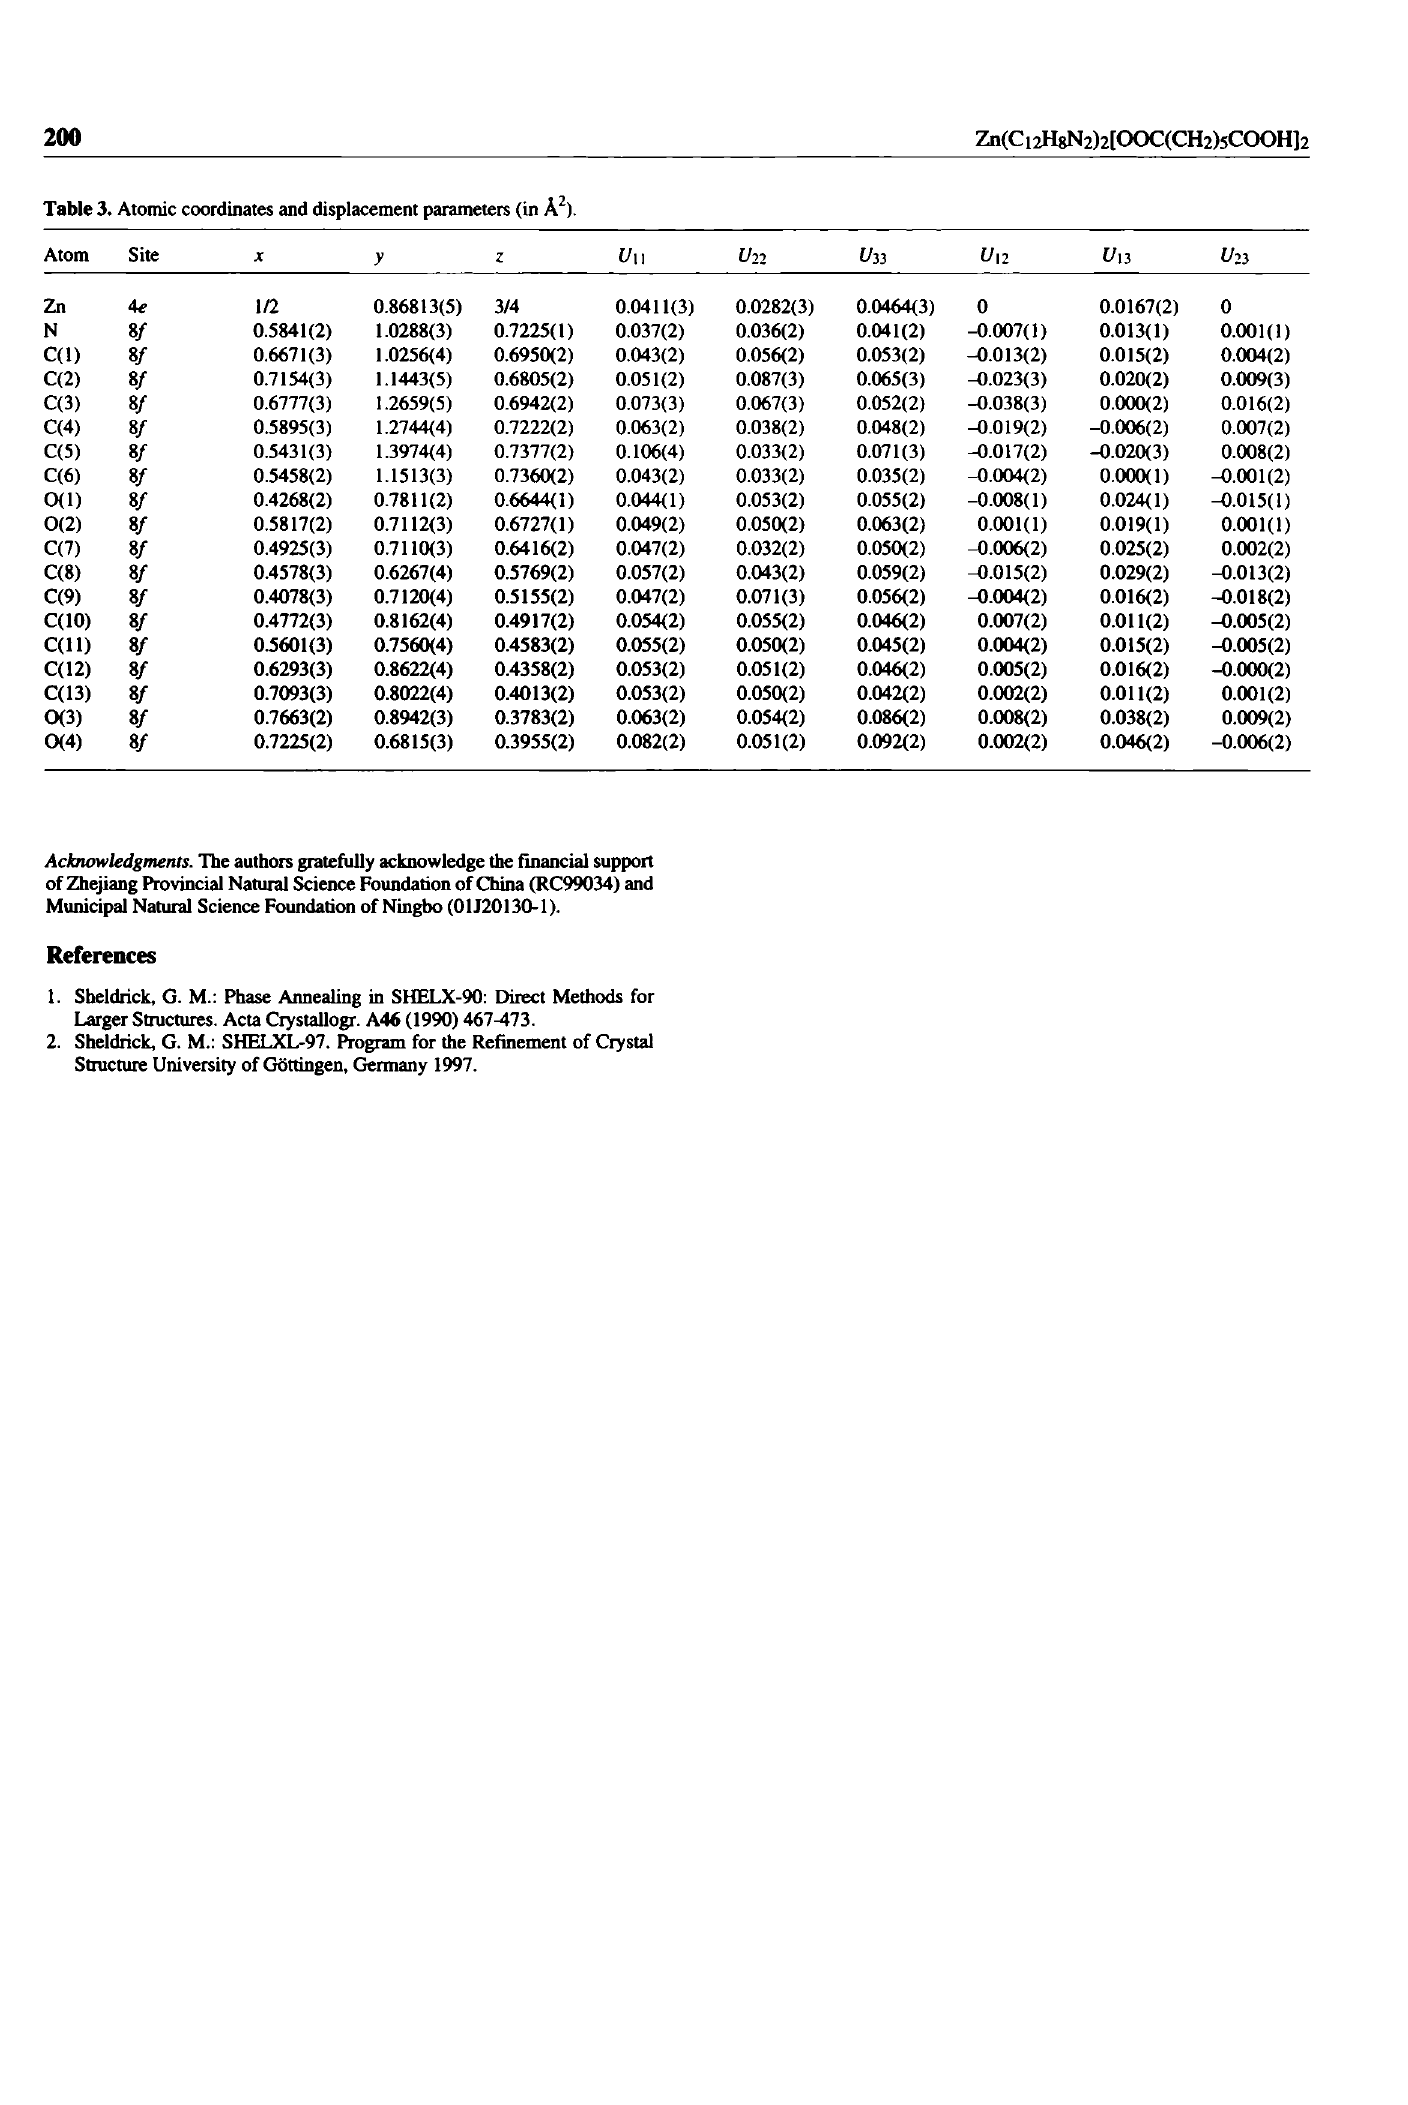
Table 3. Atomic coordinates and displacement parameters (in Ä 2